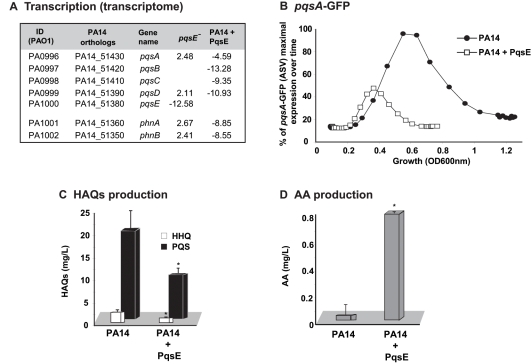
The homeostatic regulation of the signaling molecules HHQ and PQS is orchestrated by PqsE.Effect of PqsE on pqs operon gene expression, and production of HAQs and AA. (A) Fold change in expression of phn and pqs operons in pqsE
− mutant and PA14 constitutively expressing PqsE versus PA14. (B) GFP intensity derived from a pqsA-GFP(ASV) reporter fusion; (C) HAQs and (D) AA levels as assessed by LC-MS. t-tests (p = 0.001 for HHQ and p = 0.004 for PQS) showed that the difference between PA14 and PA14+PqsE is statistically significant.